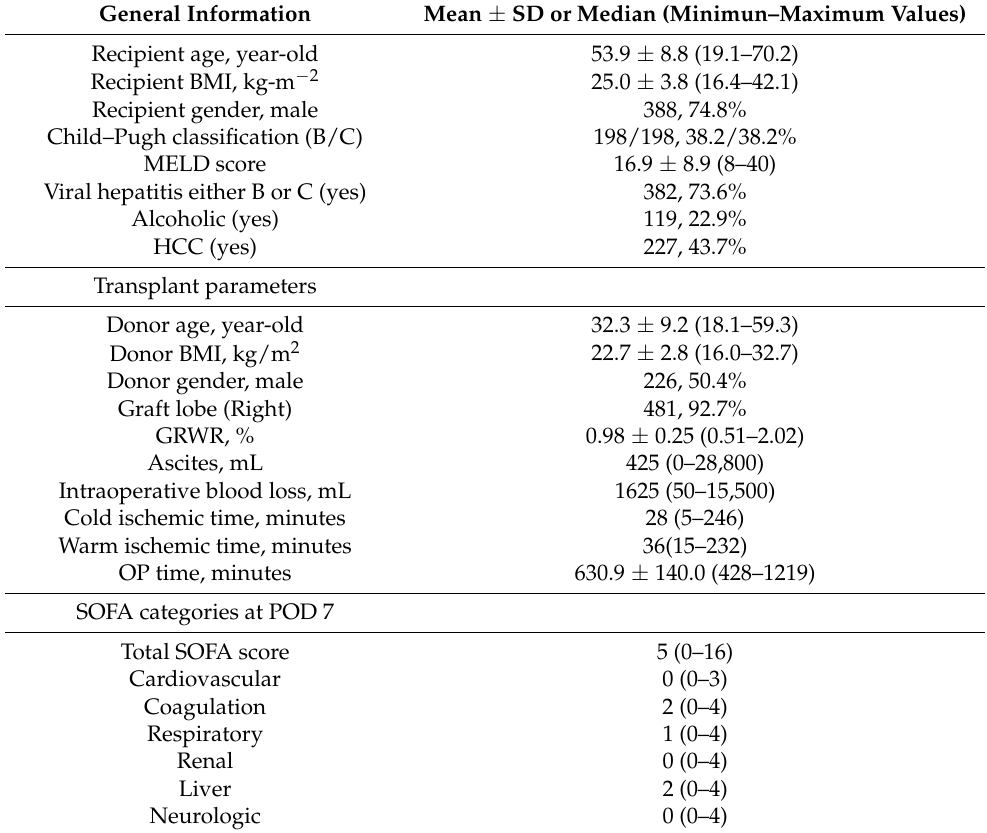
Table 1. Baseline demographics of 519 patients underwent